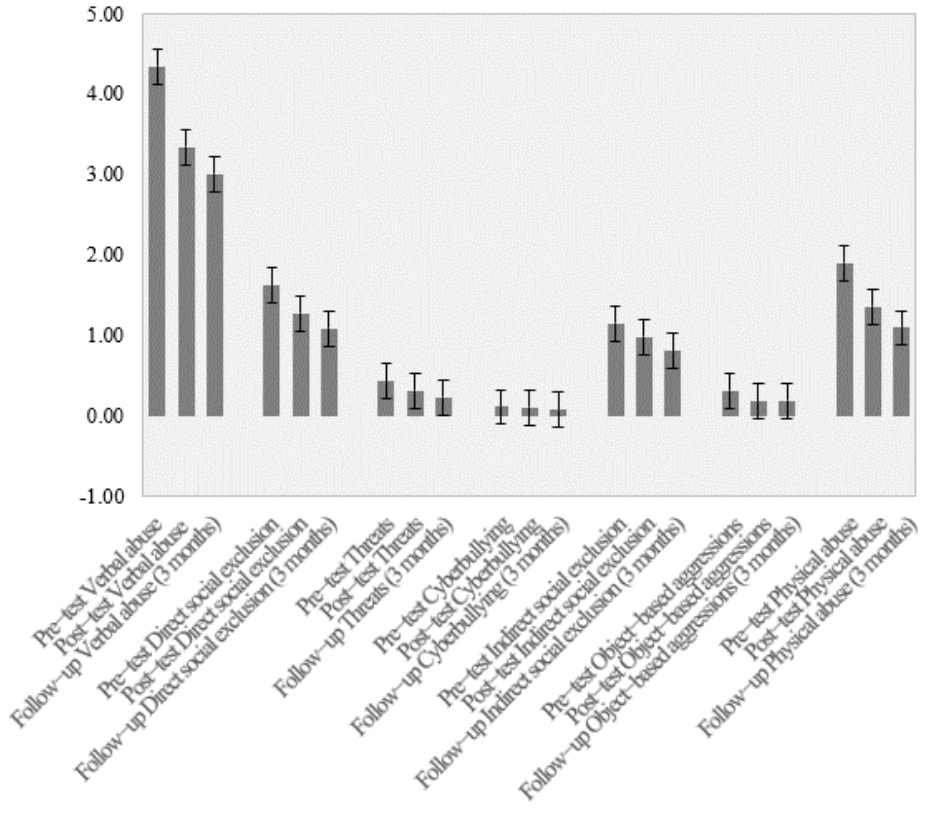
Figure 1. Mean scores in different bullying victimization behaviors for the pre-test, post-test, and 3-month follow-up.